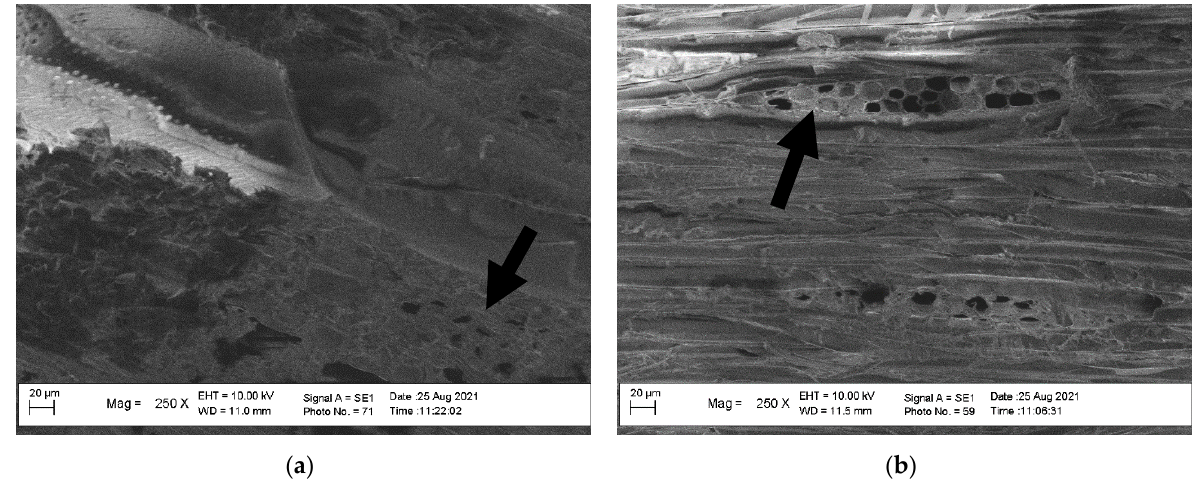
Figure 4. Scanning electron microscopy of ( a ) untreated and ( b ) polystyrene-impregnated manii wood. Remarks: The arrows indicate the voids.